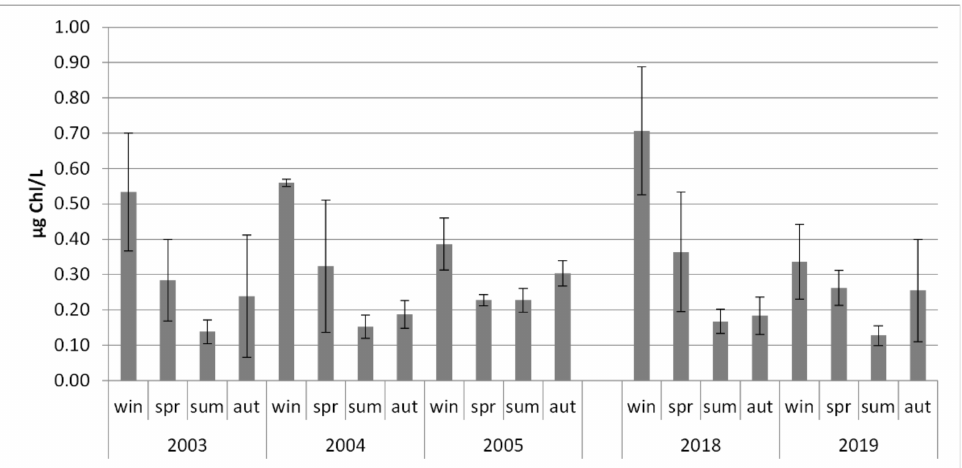
Figure 3. Seasonal autotrophic biomass as average chlorophyll-a ( µ g/L) in the 50 m-surface layer. Win: January–March; spr: April–June; sum: July–September; aut: October–December. Bars denote standard